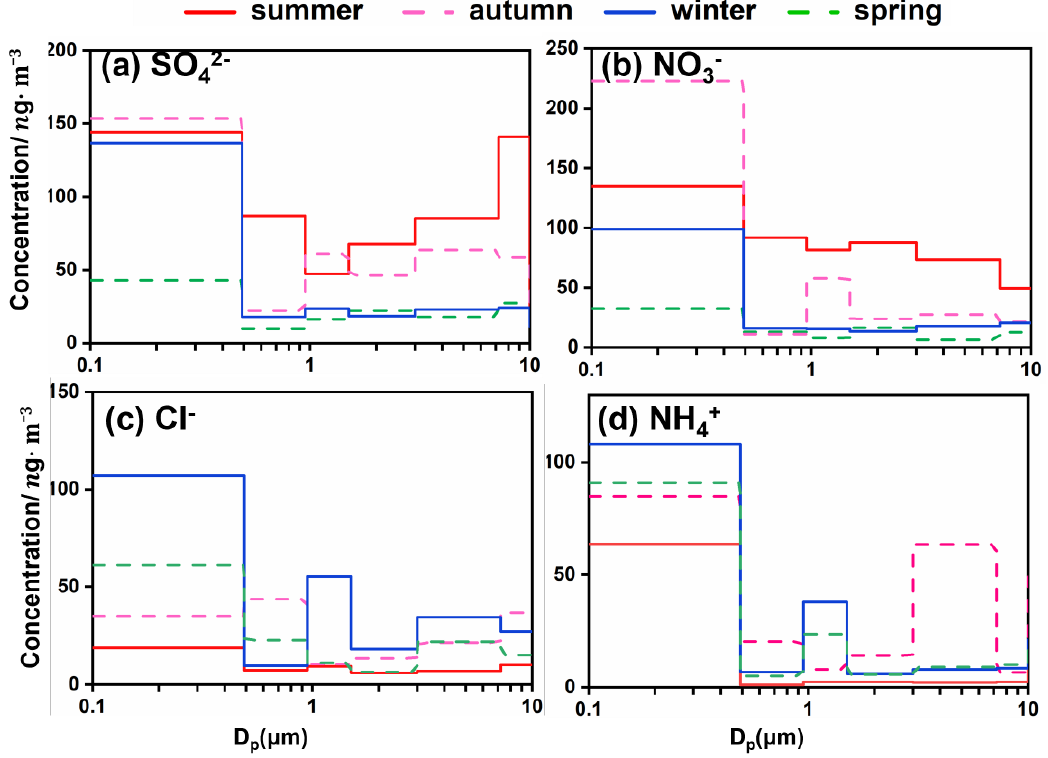
Figure 5. Concentration size distribution for WSIs during different seasons ( a − d ).